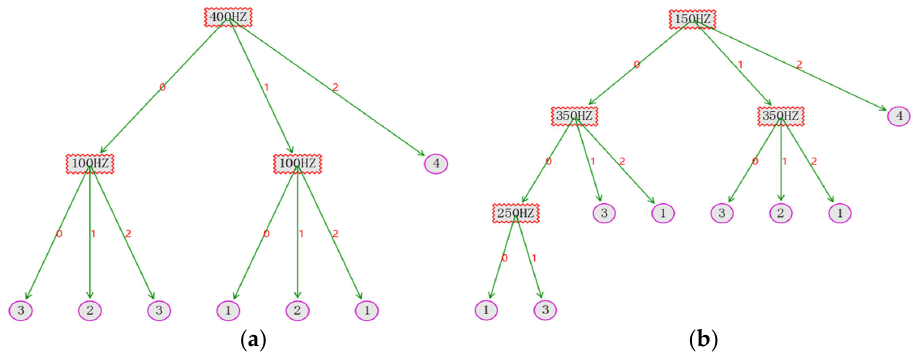
Figure 10. Decision tree model of the vibration spectrum at failure: ( a ) Even times; ( b ) Odd times.